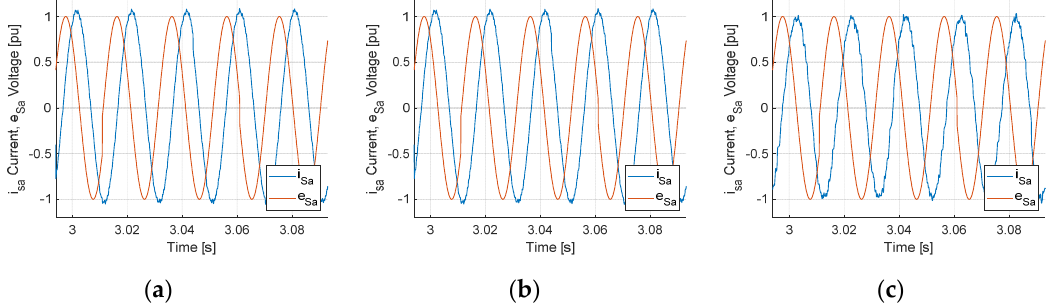
Figure 13. One phase grid current in inductive mode: ( a ) CHB ( 4000 µ F ) ; ( b ) CHB ( 1200 µ F ) ; ( c ) CHB-SDC ( 1200 µ F ) .